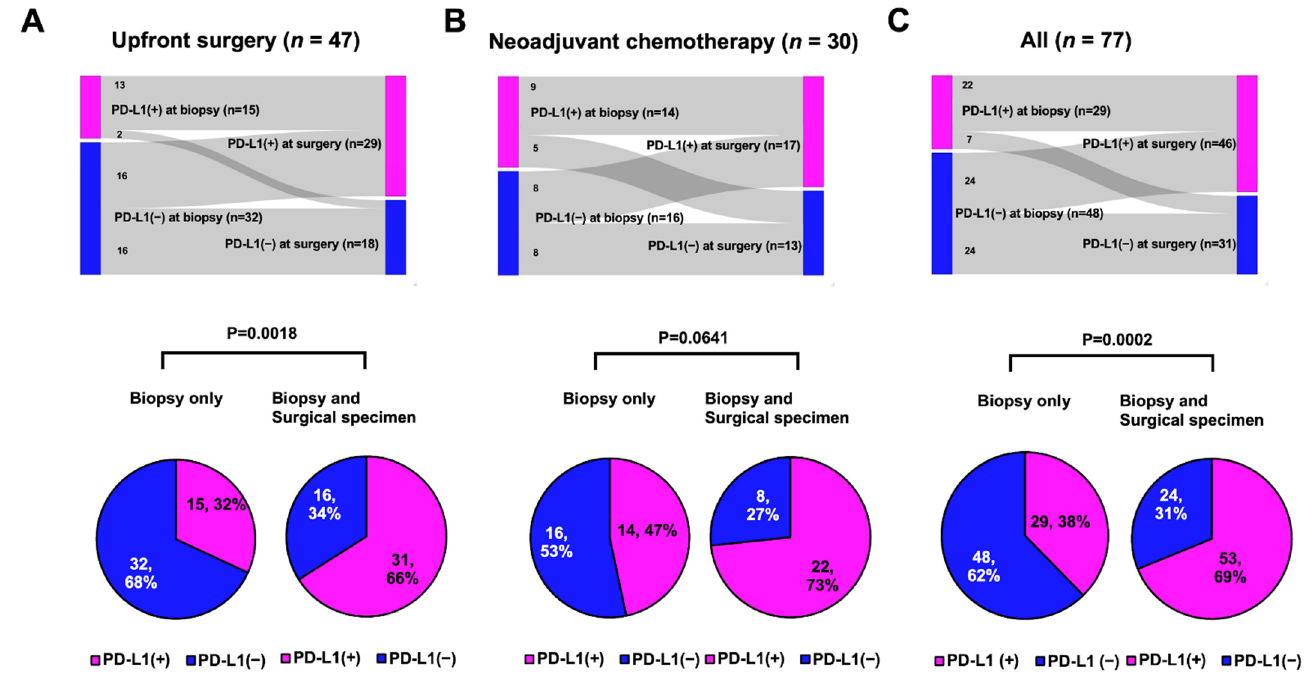
Figure 3. PD-L1 status between biopsied and surgical samples (tops) or rate of PD-L1 positive according to multiple samples (bottom): ( A ) Upfront surgery group: PD-L1-positive rates significantly increased from 32% to 66% ( p = 0.0018, Student’s t test); ( B ) Neoadjuvant chemotherapy group: PD-L1-positive rates tended to be increased from 47% to 73% ( p = 0.0641, Fisher’s exact test); and ( C ) All patients: PD-L1-positive rates were significantly increased from 38% to 69% ( p = 0.0002, Fisher’s exact test).